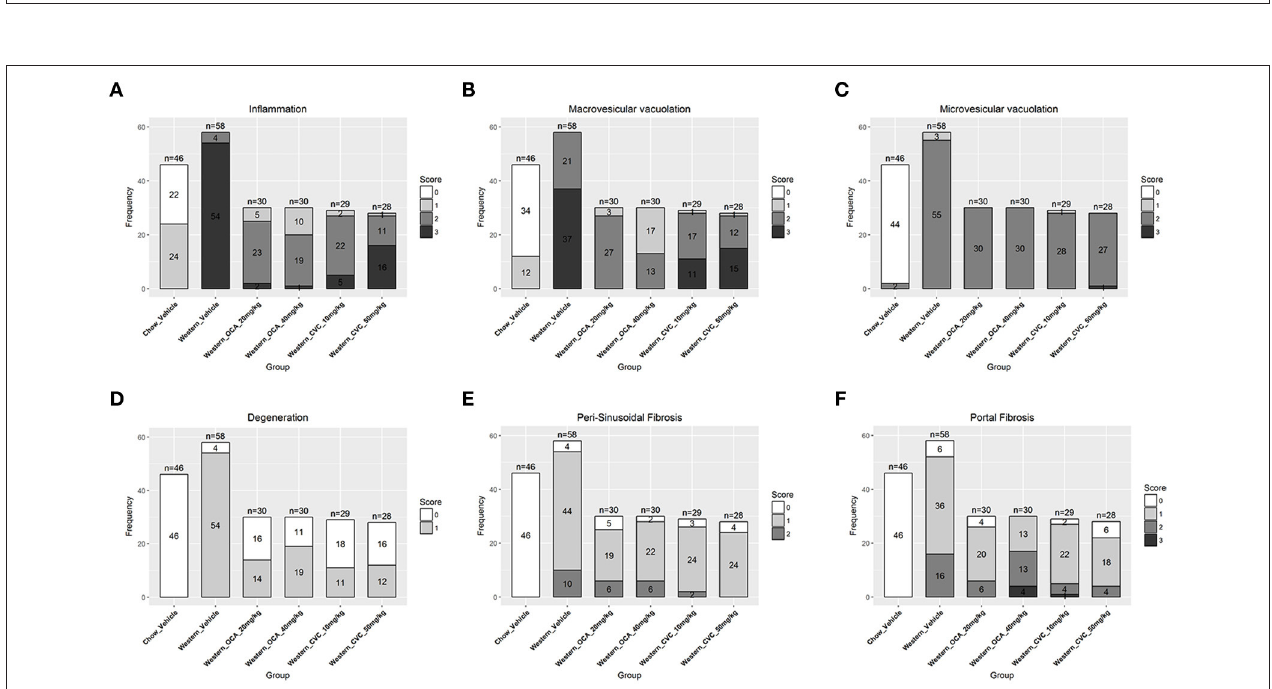
FIGURE 8 | Hepatic lesions of the NASH MIce treated with Ocaliva (OCA) and Cenicriviroc (CVC). After 77 days of drug treatment, the right and left lateral lobes of the NASH mice were collected, and analyzed. The pathological scores from both lobes of an animal were pooled when performing categorical analysis. Hepatic inflammation (A) , macrovesicular vacuolation (B) , microvesicular vacuolation (C) , hepatocyte degeneration (D) , perisinusoidal fibrosis (E) , and portal fibrosis (F) were graded. Bridging fibrosis was also analyzed, but absent in all the animals.